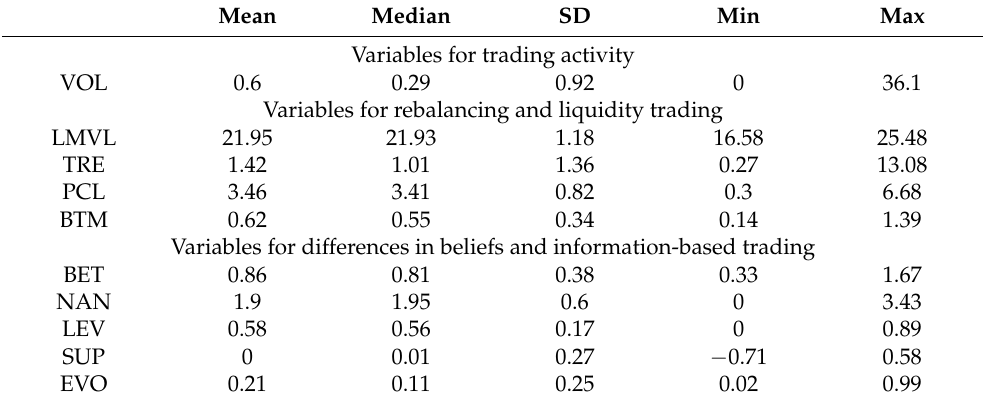
Table 1. Descriptive statistics. The table contains the mean, the median, the standard deviation (SD), the minimum (Min) and the maximum (Max) for the variables in our sample. The statistics are calculated based on the pooled sample (all firms in all time periods). The variables include: the USD trading volume (VOL) in USD 100 million, the log of the market capitalization (LMVL), the total return (TRE), the log price level (PCL), the book-to-market ratio (BTM), the stocks beta (BET), the number of analysts (NAN), leverage (LEV), earnings surprise (SUP), and earnings volatility (EVO). Mean Median SD Min Max Variables for trading activity VOL 0.6